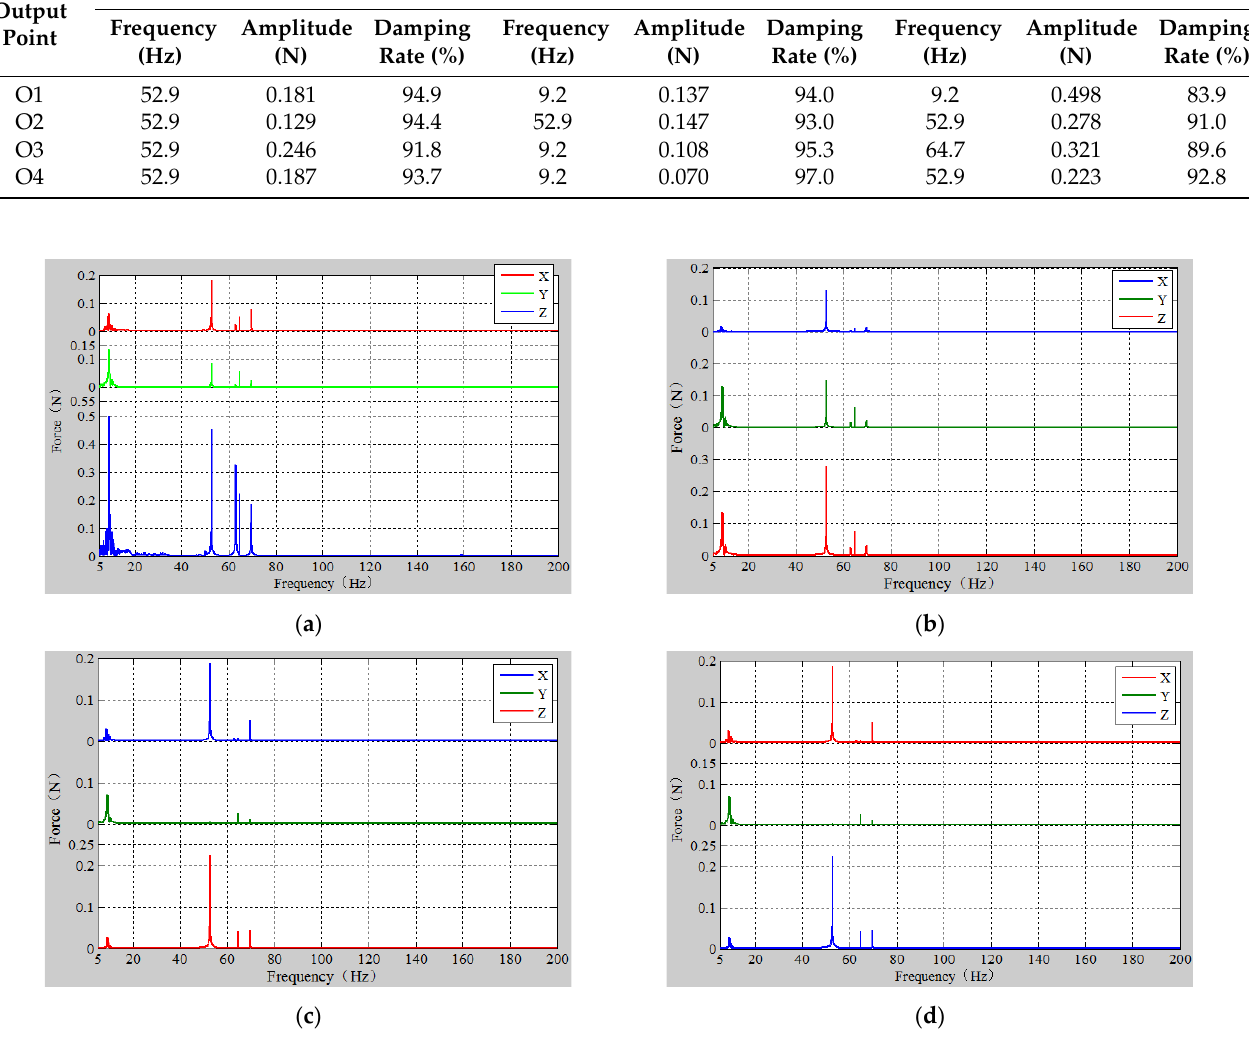
Figure 5. Reaction force data of each response point: ( a ) O1; ( b ) O2; ( c ) O3; ( d ) O4.